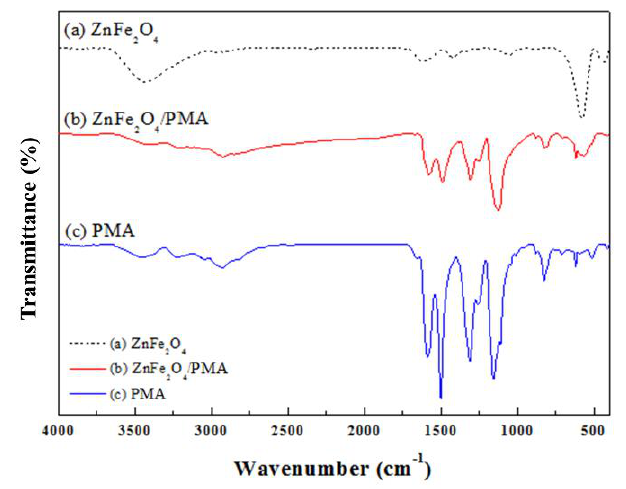
Figure 3. FT − IR spectra of ( a ) ZnFe 2 O 4 , ( b ) ZnFe 2 O 4 /PMA core-shell microspheres, and ( c ) PMA. and (533) [40]. The crystalline structure of ZnFe 2 O 4 was maintained, even though the